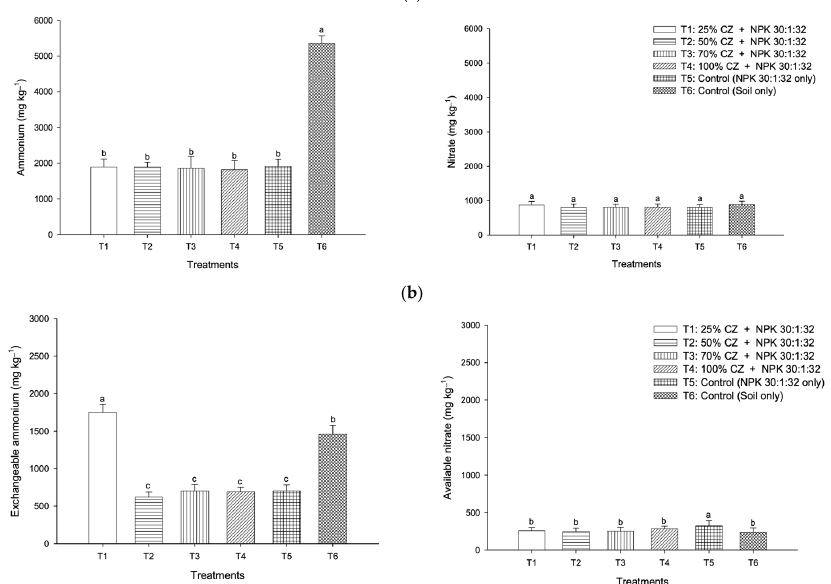
Figure 7. Mean amount of ammonium and nitrate leached ( a ) and retained ( b ) from peat soils treated with clinoptilolite zeolite throughout the pineapple growing season. Error bars indicate the standard error of the mean (n = 486). Means with different letters are significantly different using Tukey’s test with p ≤ 0.05. CZ: clinoptilolite zeolite. Agronomy 2022 , 12 , x FOR PEER REVIEW